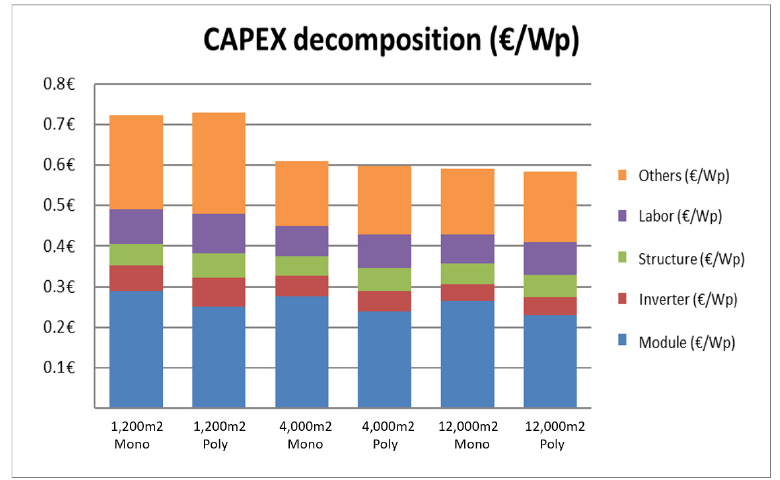
Figure 12. Normalized CAPEX decomposition.